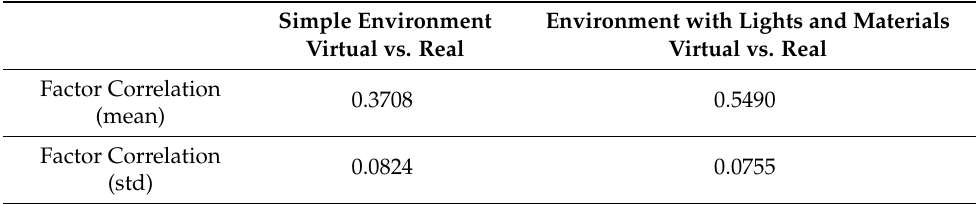
Table 1. Correlation between real-world and virtual samples.